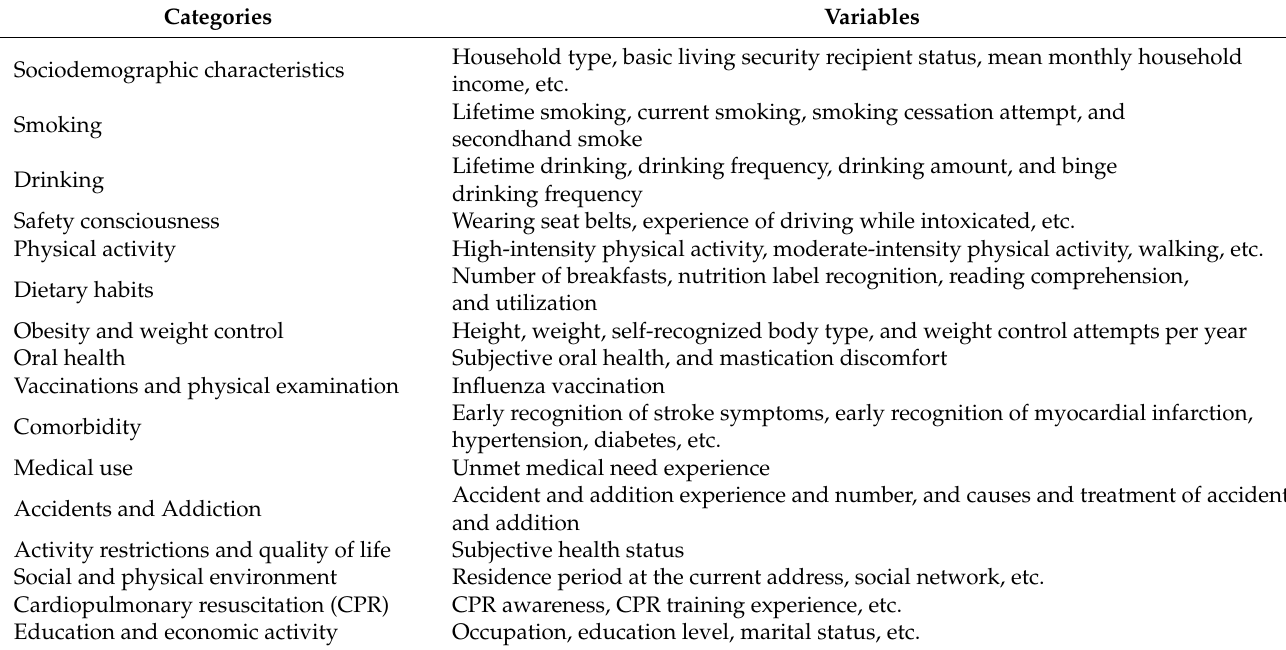
Table 1. Description of explanatory